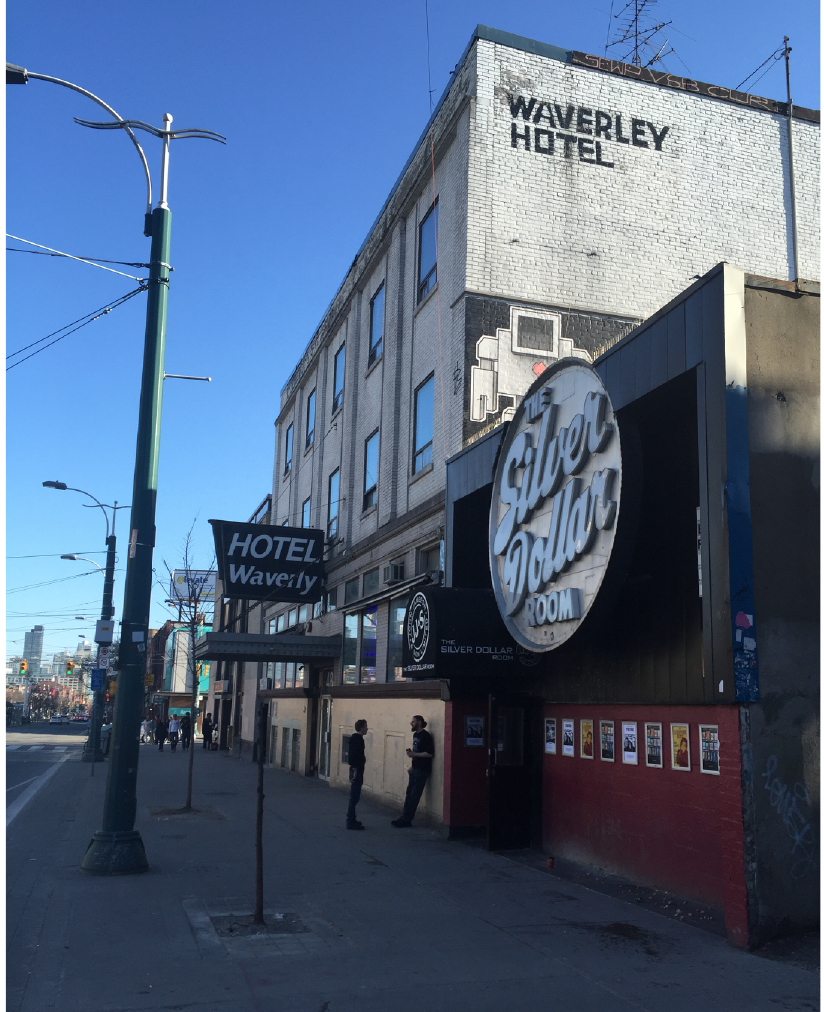
Figure 1. The Silver Dollar Room block, where the venue is located beside the Hotel